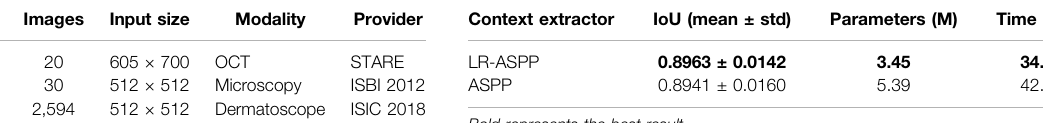
TABLE 1 | Medical image segmentation datasets for the experiments.